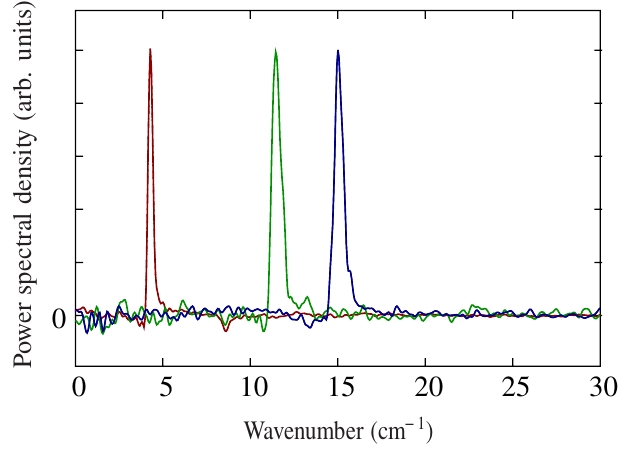
FIG. 5. (Color) Three typical emission spectra induced by the shaped laser pulses, for three different modulation frequencies. Each spectrum is rescaled to its maximum